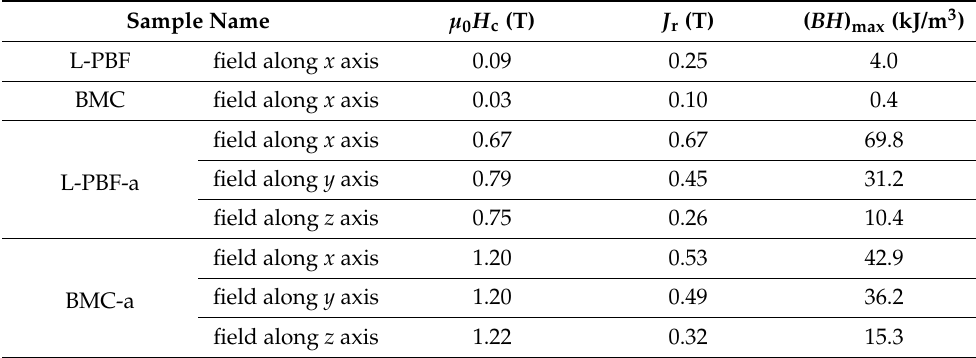
Figure 3. Room temperature hysteresis loops of 3D-printed Fe73.8-Pr20.5-Cu2.0-B3.7 in the as-built state ( L-PBF ) (light blue) and annealed state ( L-PBF-a ) (blue) and the reference BMC material in the as-cast state ( BMC ) (light gray) and annealed state ( BMC-a ) (gray) in comparison. The magnetic field was applied along x direction (L-PBF: laser scanning direction, BCM: parallel to mold wall). Table 2. Overview of the magnetic properties coercivity µ 0 H C , remanence J r and maximum energy density ( BH ) max of BMC-a and L-PBF-a measured in three axes. Additionally, the magnetic properties of the as-built/as-cast state are listed.